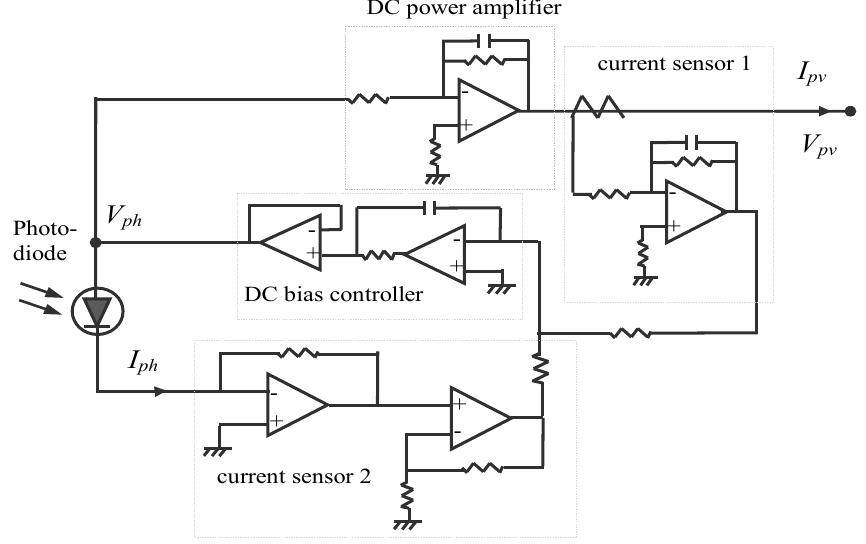
Figure 4. PV simulator based on I-V magnifier of photo-diode [9,10].